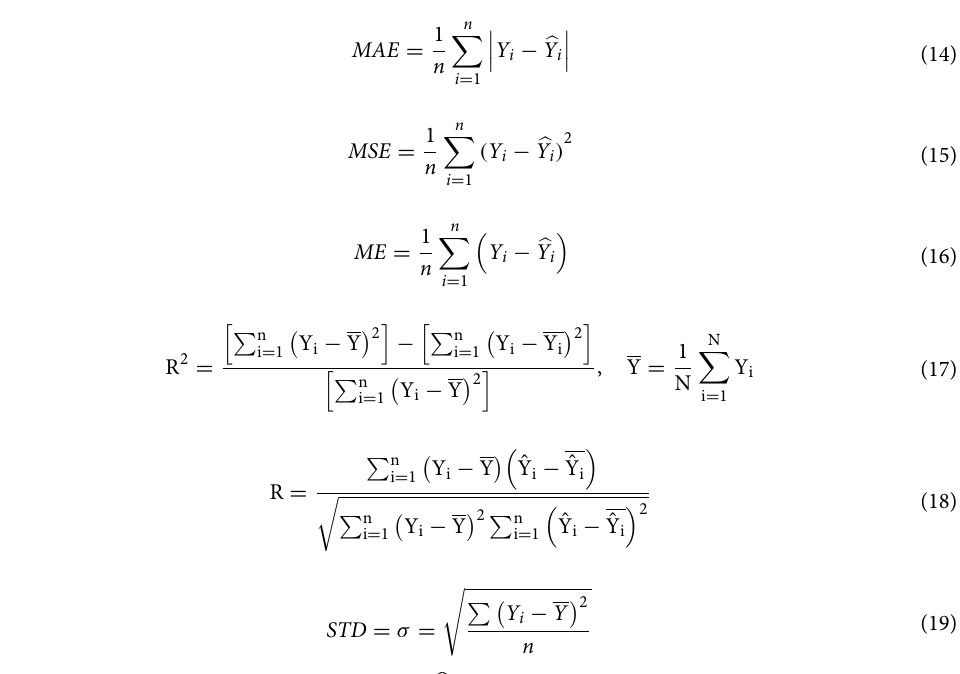
Figure 6. The loss graph of Concat_CNN model during training